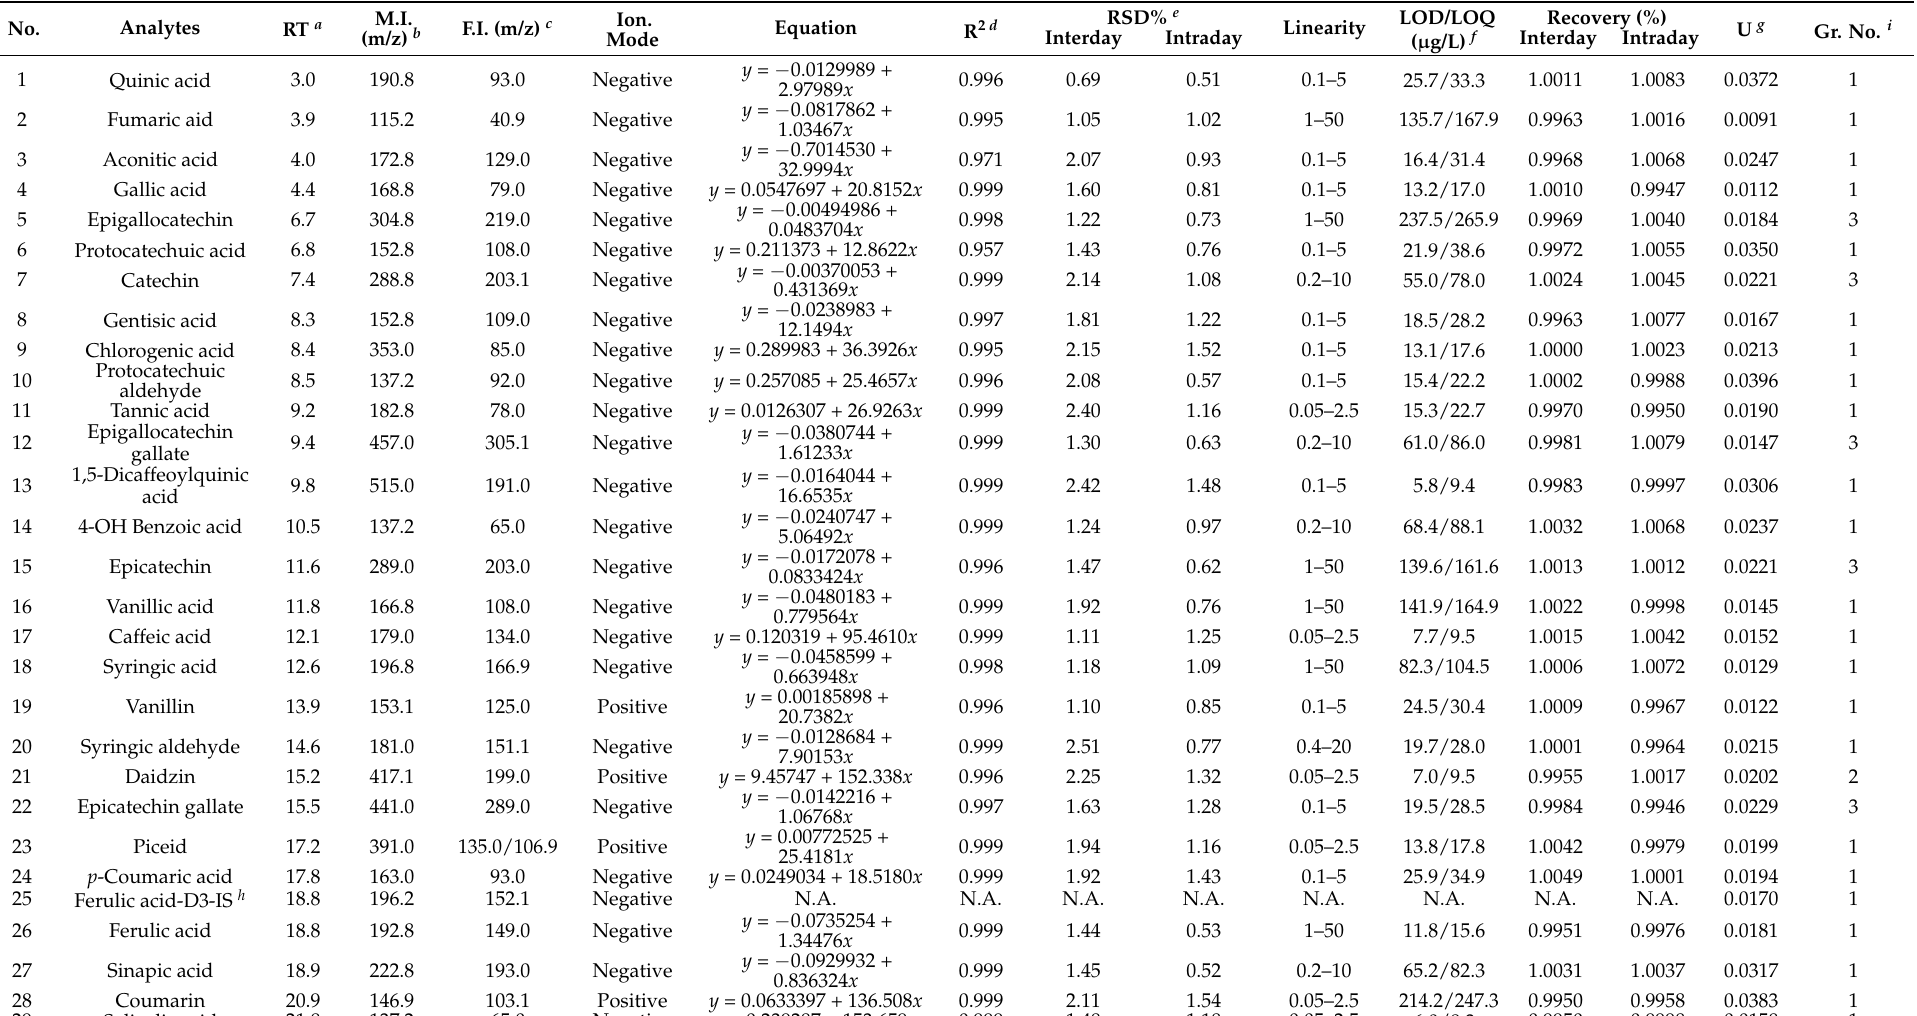
Table 1. Analytical method validation parameters that belong to the LC-MS/MS